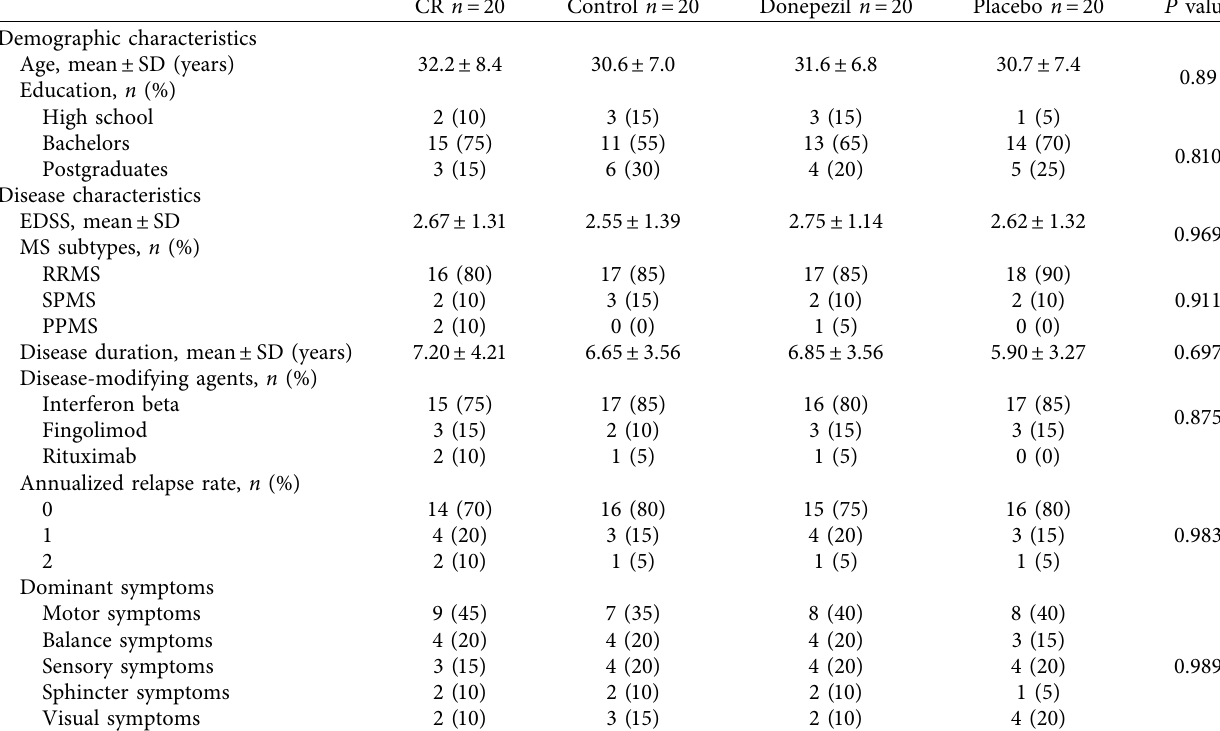
Table 1: Baseline demographic and clinical